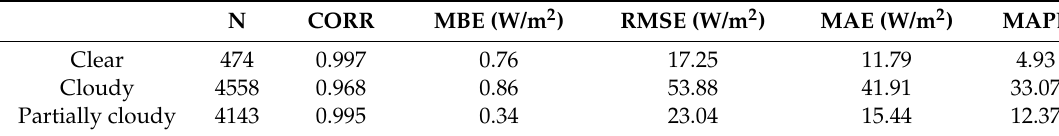
Table 4. As in Table 2, but for the SSI_HRV product with respect to SSI_Ground. N